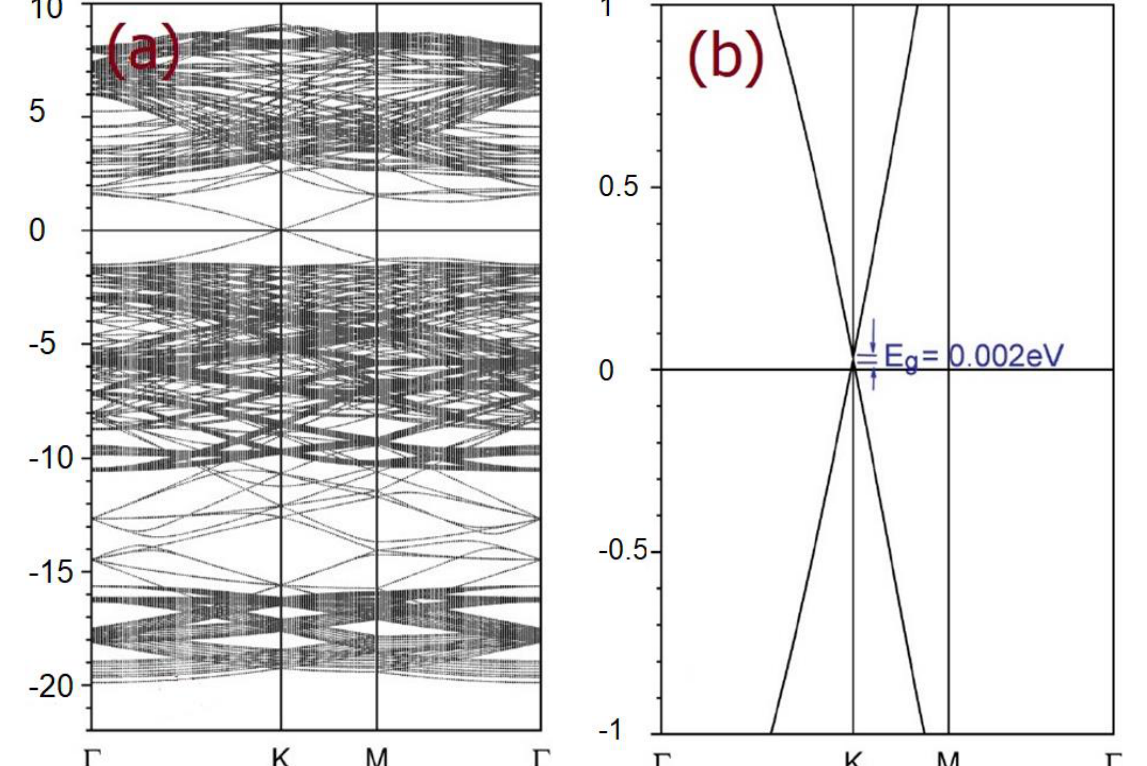
√ √ 13 × 13 -graphene on 2